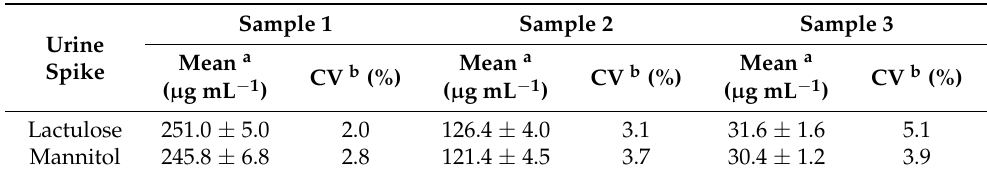
Table 4. Inter-assay variability of lactulose and mannitol in three urine samples each repeated 10 times in consecutive assay runs.